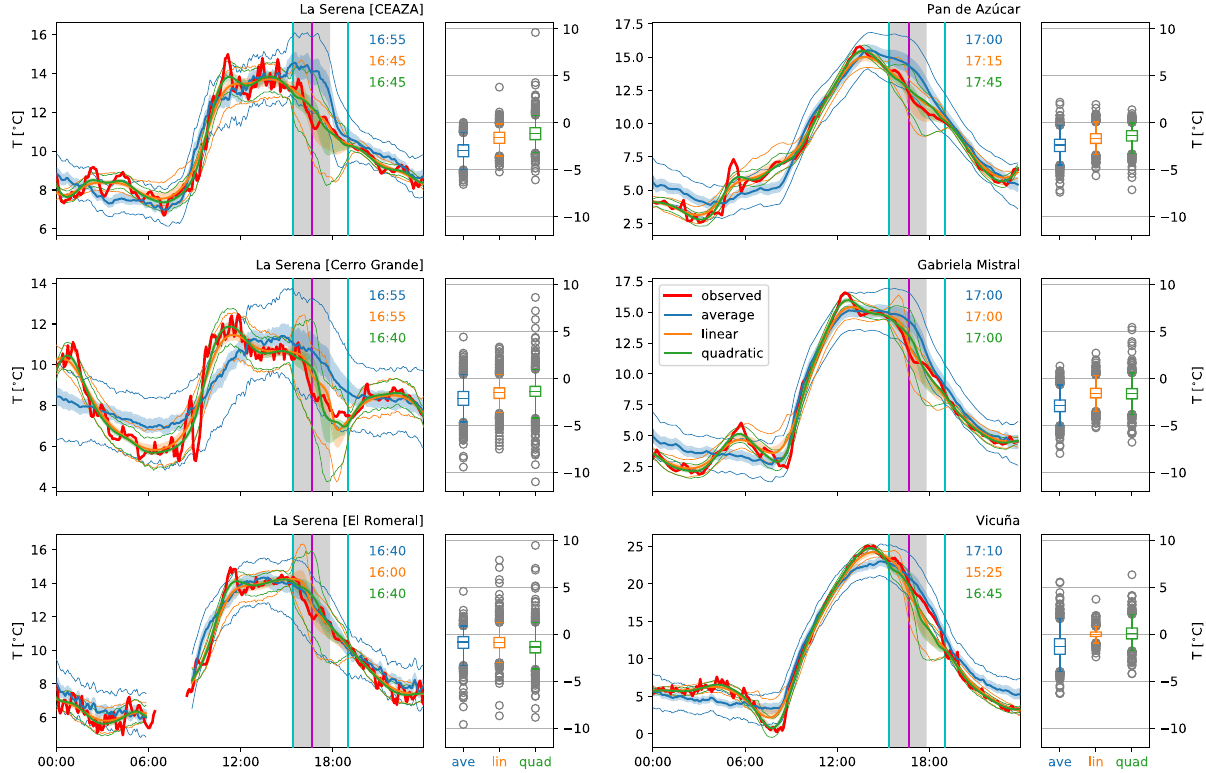
Figure 2. Observed 2m air temperatures and reference estimates as in Fig. 1, but with estimates obtained from unweighted averages over a number of ‘similar’ days and local linear and quadratic regression (a type of